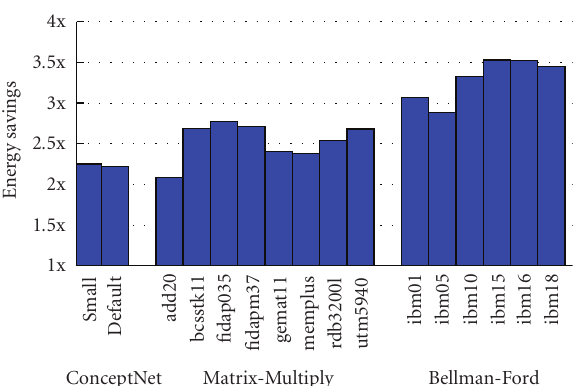
Figure 22: Dynamic energy savings at 25